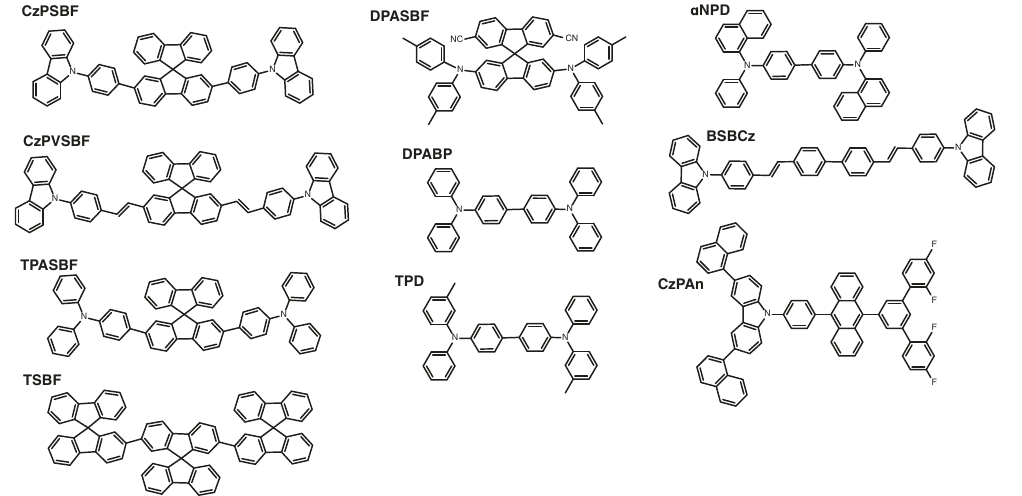
Fig. 2 Group II: thin fi lm organic fl uorescent materials investigated in this work. Most of these thin fi lm materials are chosen from ref. 5 , with a few up- to-date reported